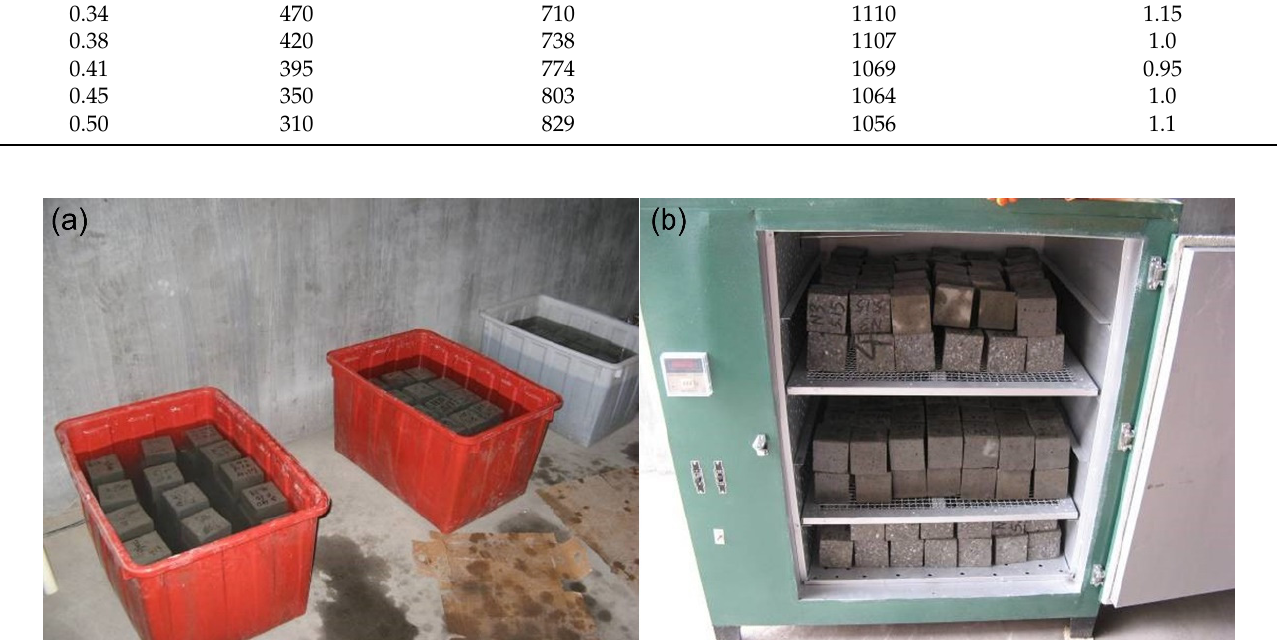
Figure 2. DW process with sulfate attack: ( a ) immersing; ( b ) drying.